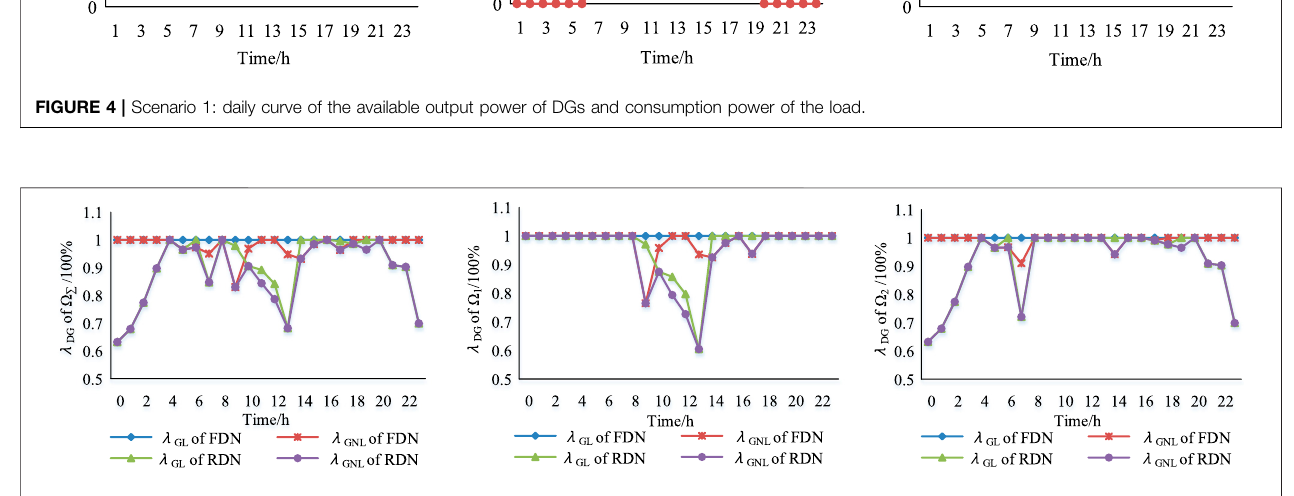
FIGURE 5 | Scenario 1: daily GLAR and GNLAR curve of both the FDN case and RDN case.